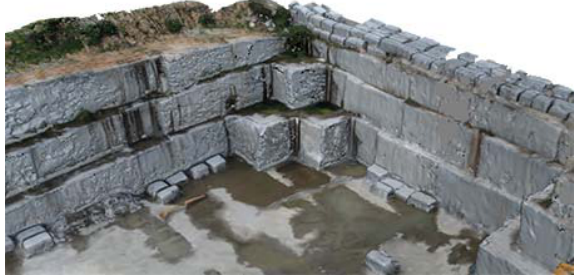
Figure 4. Photorealistic 3D model of the quarry.